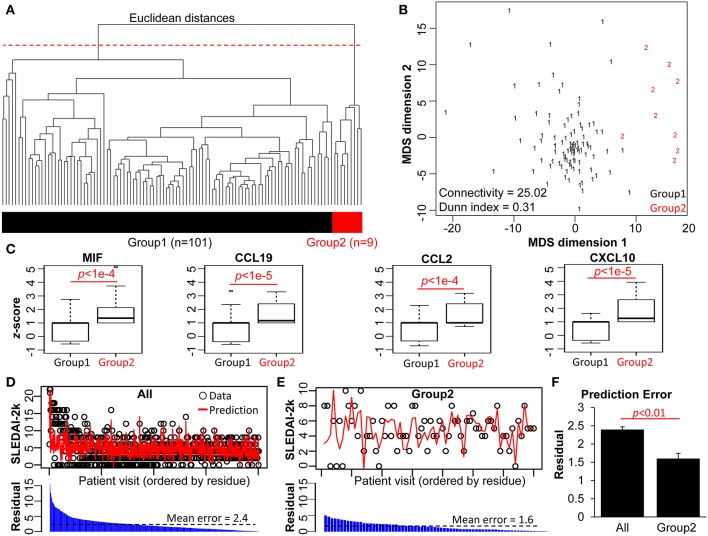
Magnitude-based clustering of SLE patients based on 17 biological parameters. (A) The dendrogram of the pairwise Euclidean distances of the 110 SLE patient pathology profiles. An arbitrary cut-off of 90% of the dendrogram height (red dashed line) produces two groups of patients (bi-colored bar). (B) Isotonic MDS plot of the Euclidean distances between the 110 patients. Group 2 (red) exhibits lower intra-cluster similarity compared to Group 1 (black). The Connectivity and Dunn indices (bottom left) indicate the quality of the clustering method. (C) Boxplot comparison of the two patient groups, based on z-normalized serum cytokine parameters. (D,E) Results from LOPO multiple linear regression to predict the disease activity (SLEDAI-2K) of each patient visit based on the blood and urinary parameters, performed on (D) all patients vs. (E) patients from Group 2. Black circles represent actual SLEDAI-2k values from the patient cohorts, while red lines represent the predictions from the LOPO linear regression model. All data points were arranged in descending order of the residuals. (F) Comparison of prediction error of Group 2 patients vs. all patients without grouping information. With group stratification, Group 2 exhibits strong power to predict SLEDAI-2K score, based on the low mean residual (absolute error between the predicted and actual SLEDAI-2K scores), compared to all data.